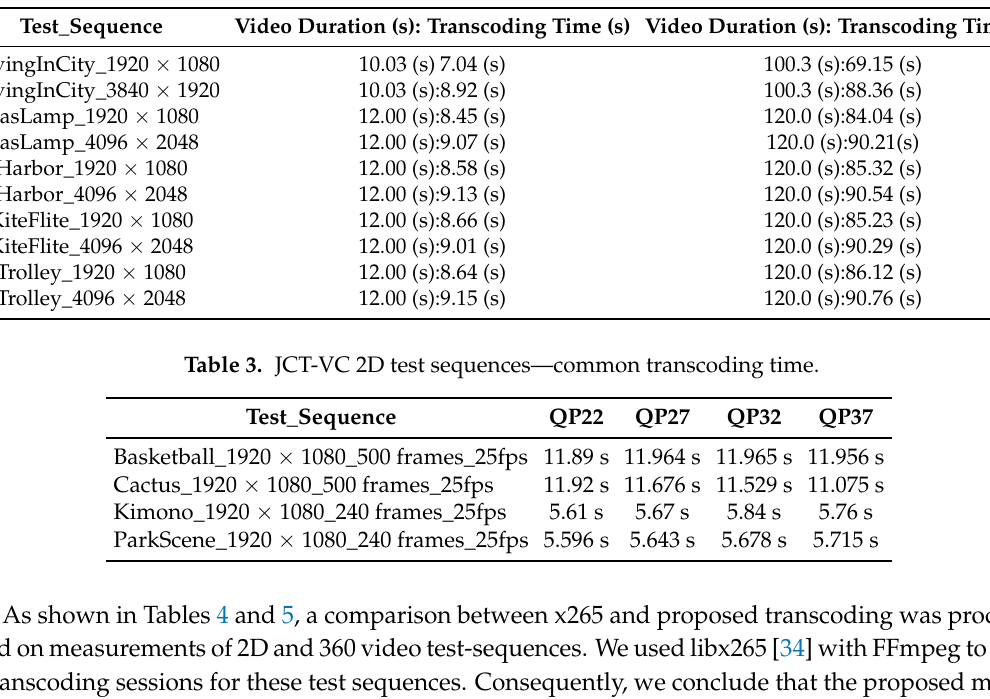
Figure 15. The DrivingInCity test sequence H.264/AVC to HEVC—six 1080p transcoding sessions. Table 2. The 360 test sequences—common transcoding time.